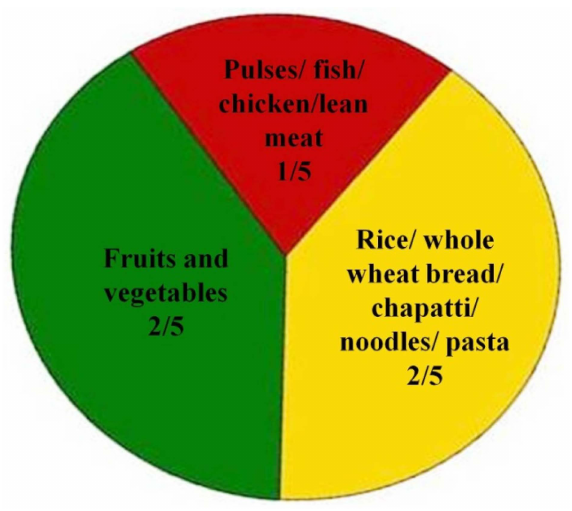
Figure 2. Mauritian Plate Model. Source: Ministry of Health and Quality of Life, Mauritius.